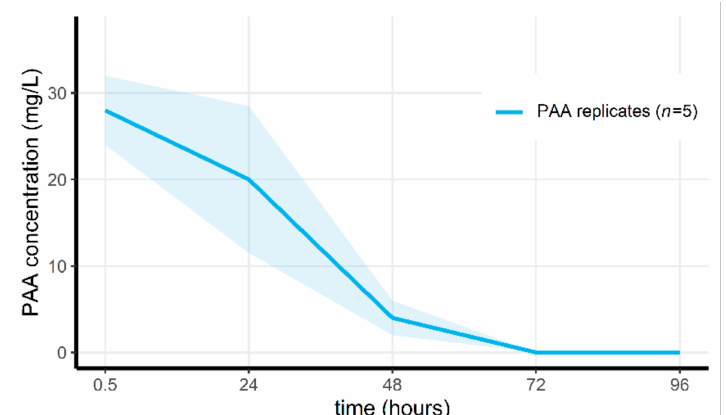
Figure 3. Mean measured PAA concentration through time in the PAA-treated replicates of the pilot microcosm experiment. Shaded areas indicate the mean ± standard deviations.